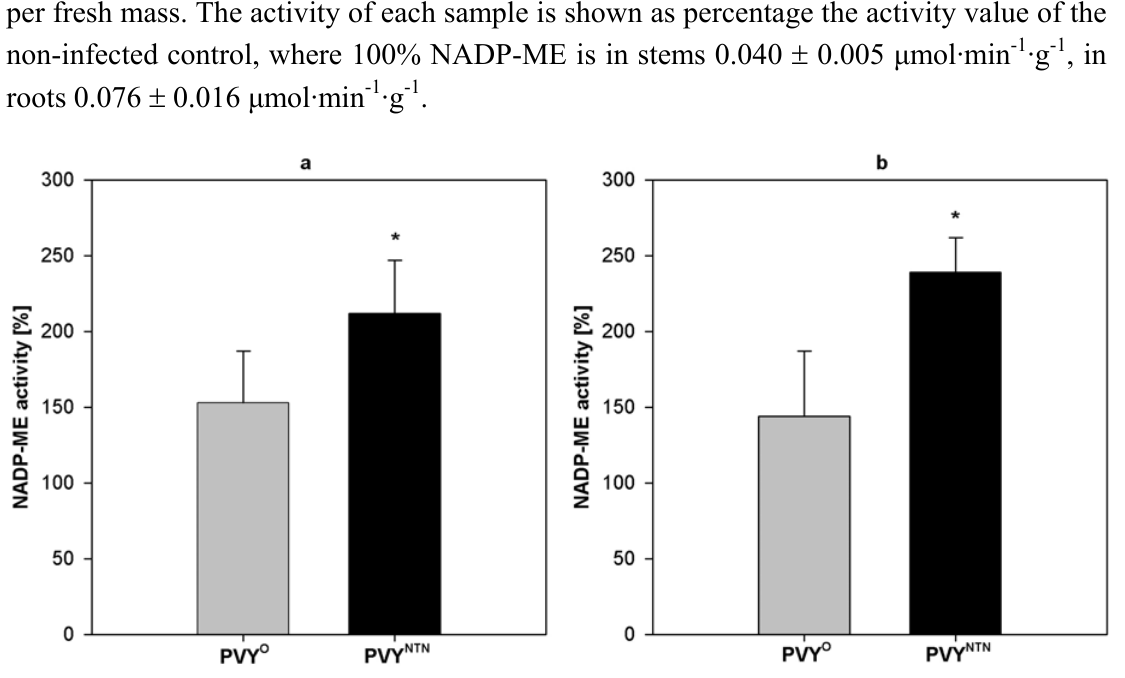
Figure 3. Activities of NADP-ME from Nicotiana tabacum L. stems (a) and roots (b) collected 11 th day after PVY O inoculation and 13 th day after PVY NTN inoculation calculated per fresh mass. The activity of each sample is shown as percentage the activity value of the non-infected control, where 100% NADP-ME is in stems 0.040 ± 0.005 μ mol·min -1 ·g -1 ,